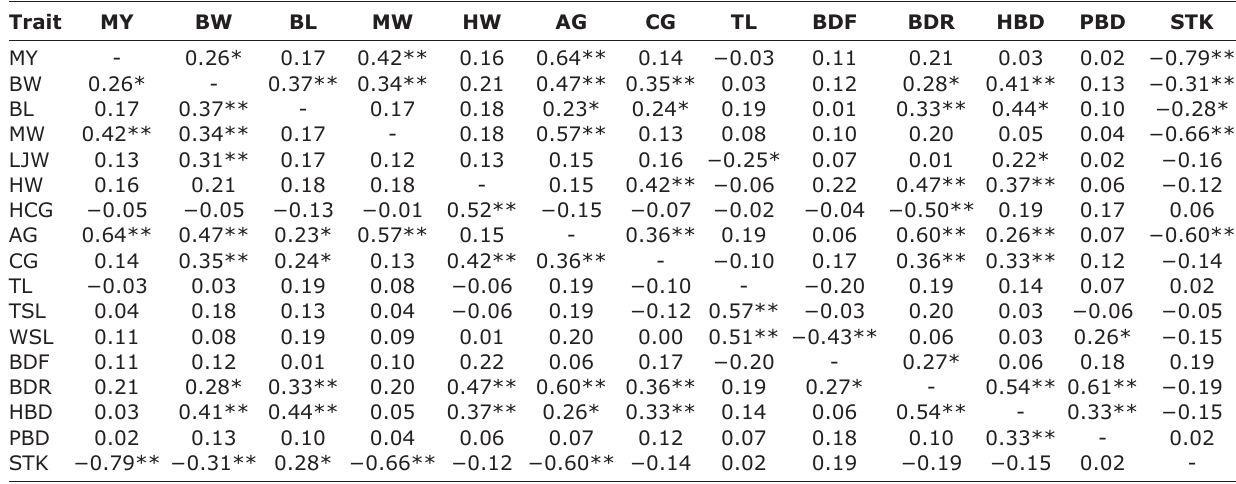
Table-2: Correlation between MY and body parts measurements in the Murrah buffaloes. Trait